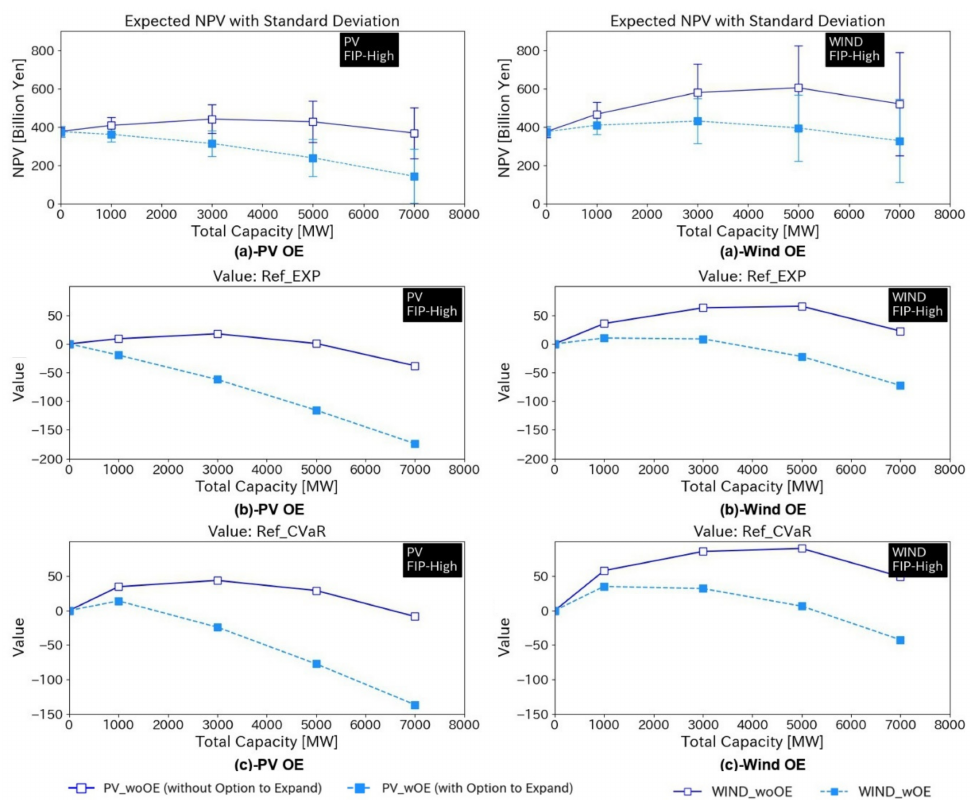
Figure 12. Results of option to expand in case of high FIP: ( a ) Expected NPV with standard deviation, ( b ) Value in case of high RFP and ( c ) Value in case of low